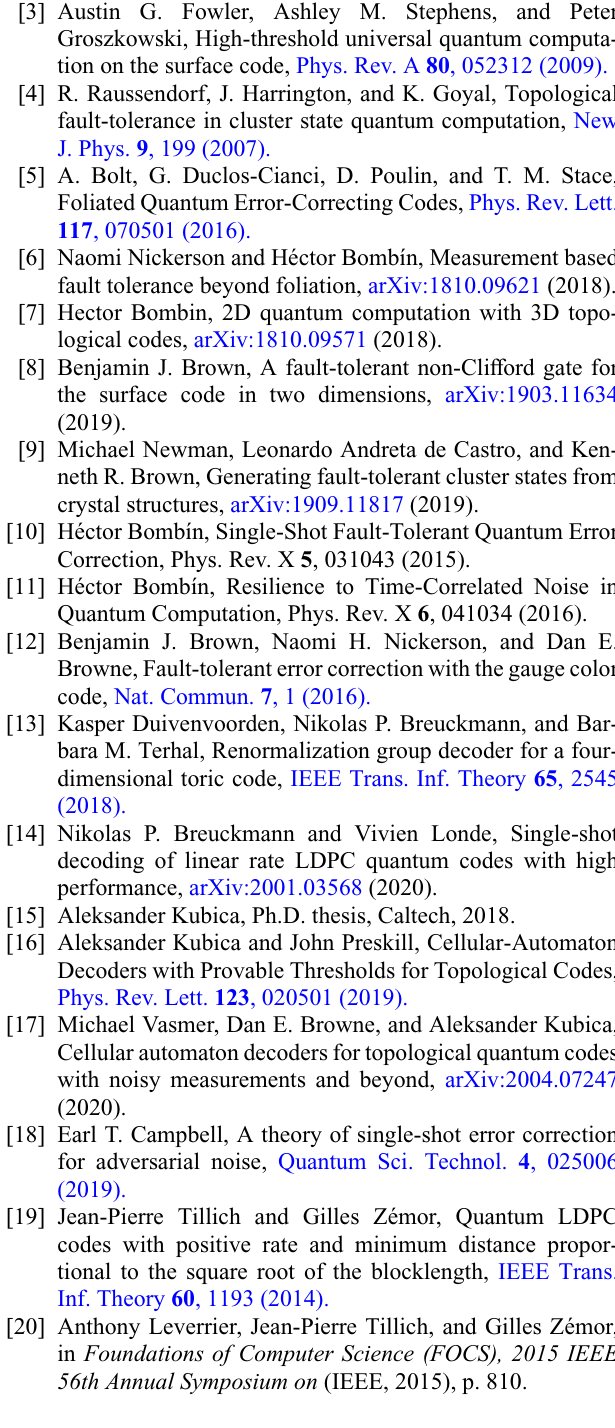
procedure for code-capacity noise (no measurement errors) and for eight rounds of single-shot error